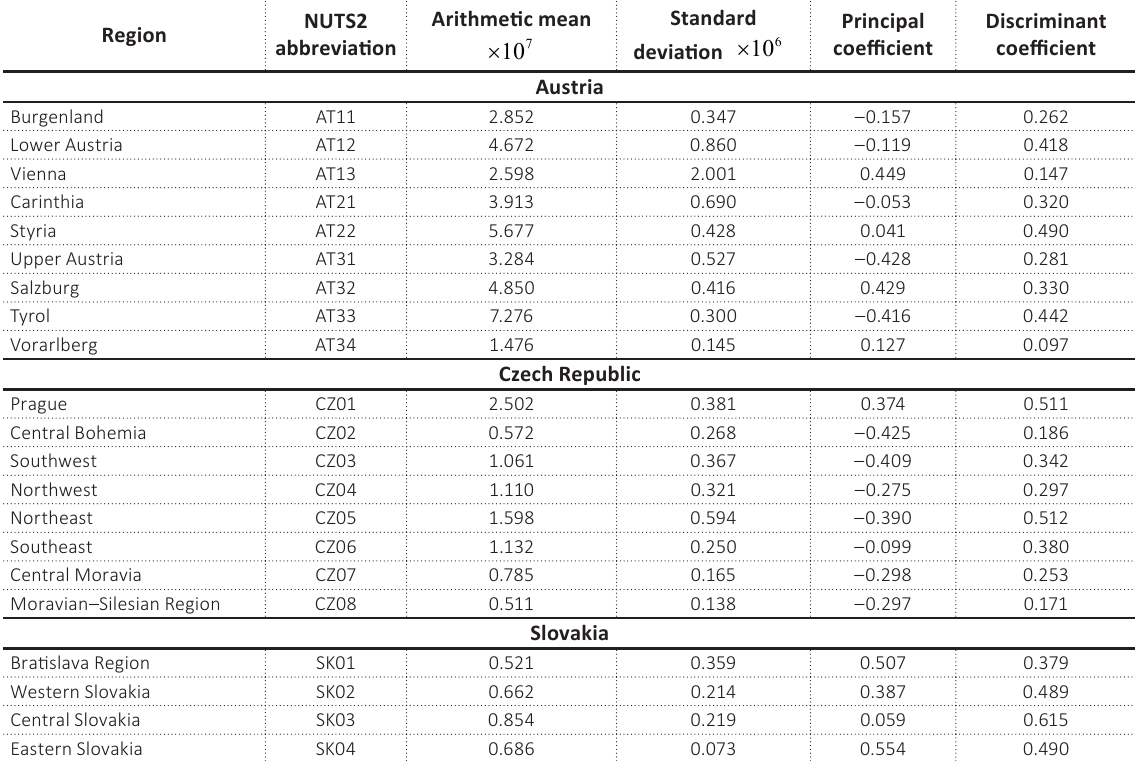
Table 1. Capacity for the selected Central European countries on descriptive statistics, principal component analysis, and discriminant